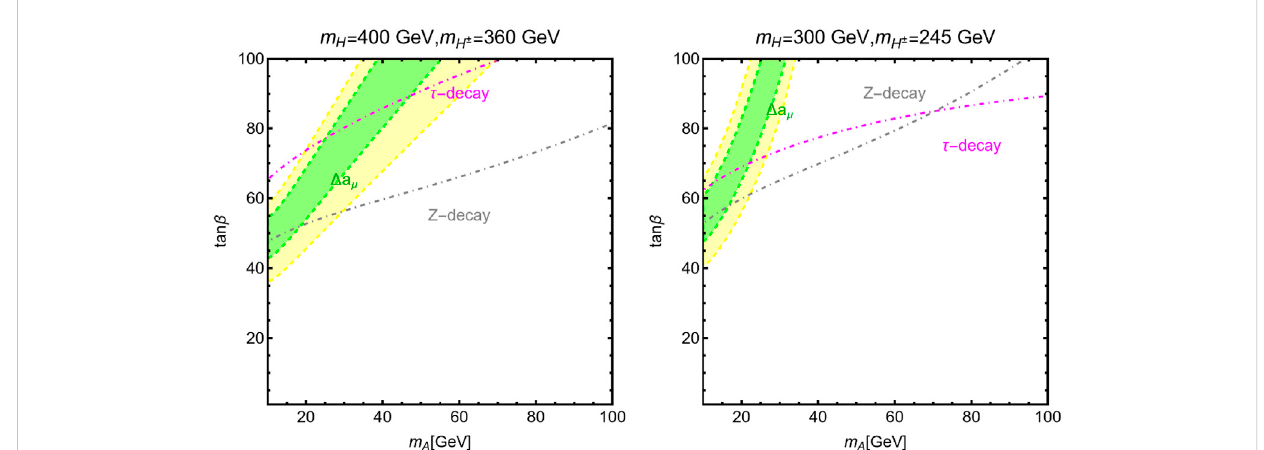
FIGURE 5 Regions providing a viable fi t of the ( g − 2) μ anomaly at 1 σ (green) and 2 σ (yellow) in the plane [ M A , tan β ] for two assignments of ( M H , M H ± ) , namely, (400,350) and (300, 245) GeV. The dot-dashed lines represent the bounds from violation of lepton universality in decays of the Z boson and τ -lepton (regions above the lines are